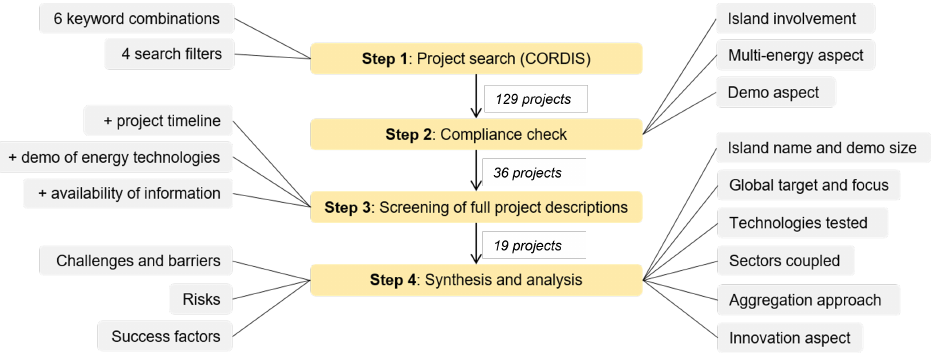
Figure 1. Methodology of the systematic analysis of research